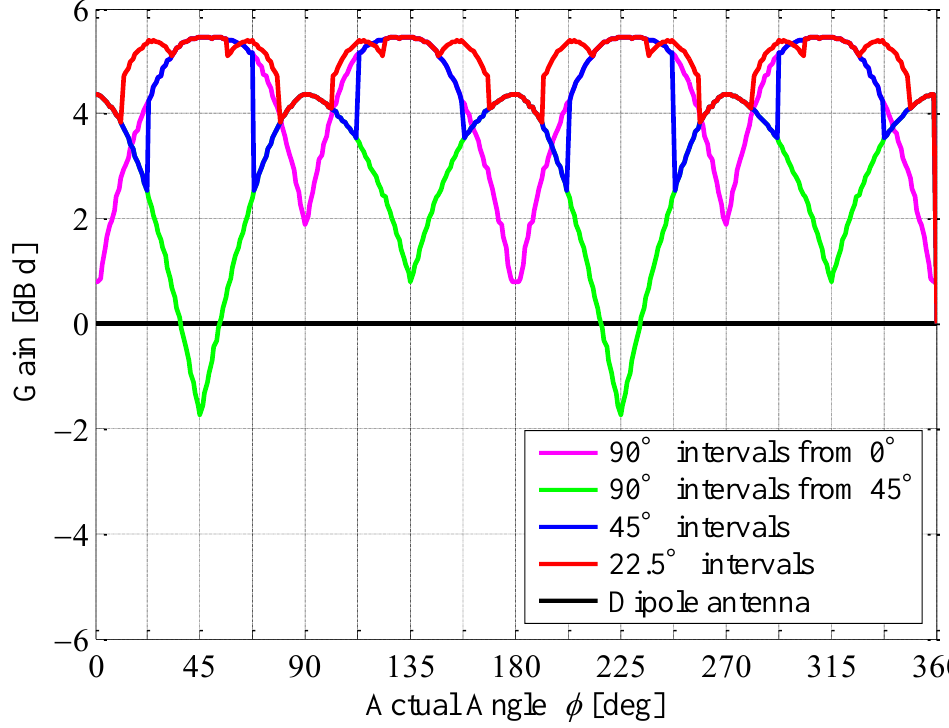
Figure 19. Radiation gain with respect to the angle of the incoming wave.